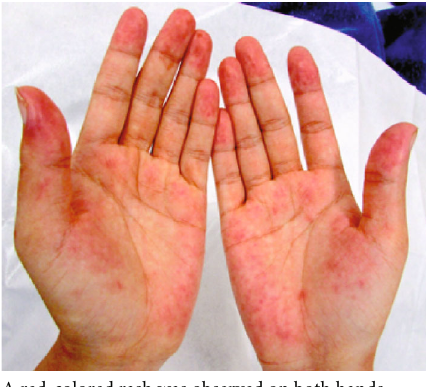
Table 1: Laboratory results of coagulation studies.